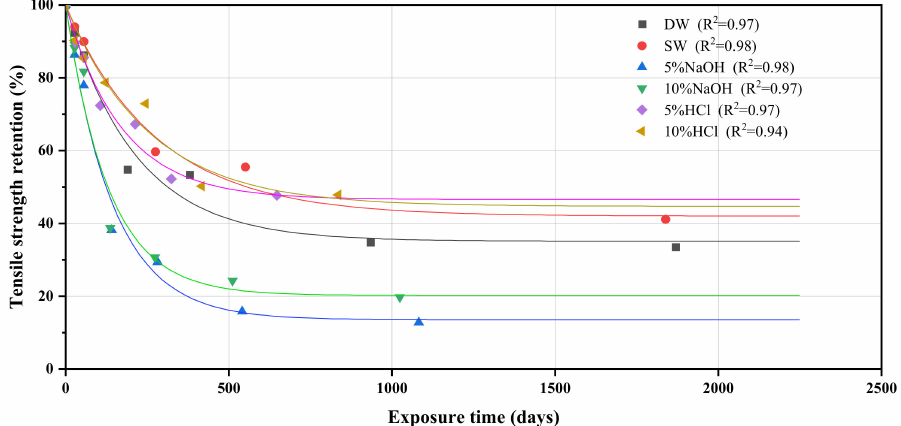
Figure 15. Predicted relationship between residual tensile strength and service life at the temperature of 22.3 ◦ C for the GFRP exposed to various